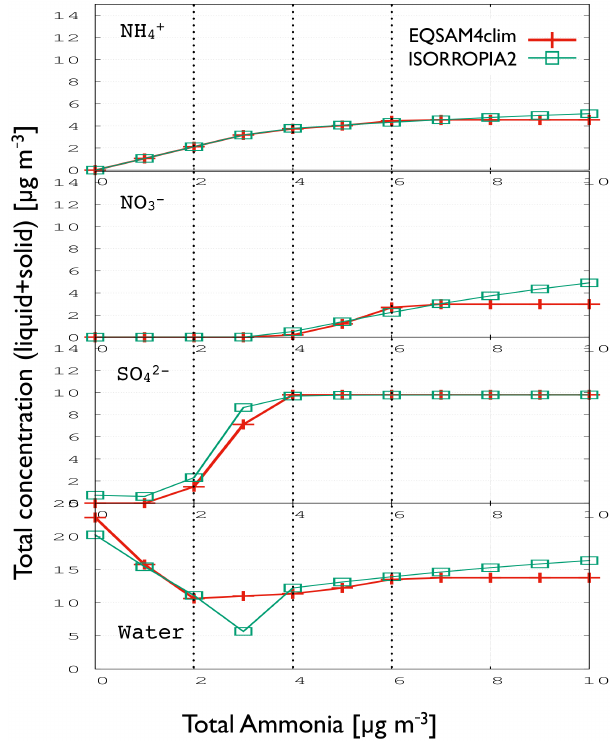
Figure 5. Mixed solution composition of NH 4 NO 3 and ( NH 4 ) 2 SO 4 as a function of total ammonia at T = 298 . 15 [ K ] and RH = 70 [ % ] , as defined in Seinfeld and Pandis (2006) for their Fig. 10.23. EQSAM4clim (red crosses) and ISORROPIA II (green squares) for [ TS ] = [ TN ] = 10 [ µgm − 3 ( air ) ] . Note that at zero ammonia, H 2 SO 4 is at a maximum; shown in Fig.